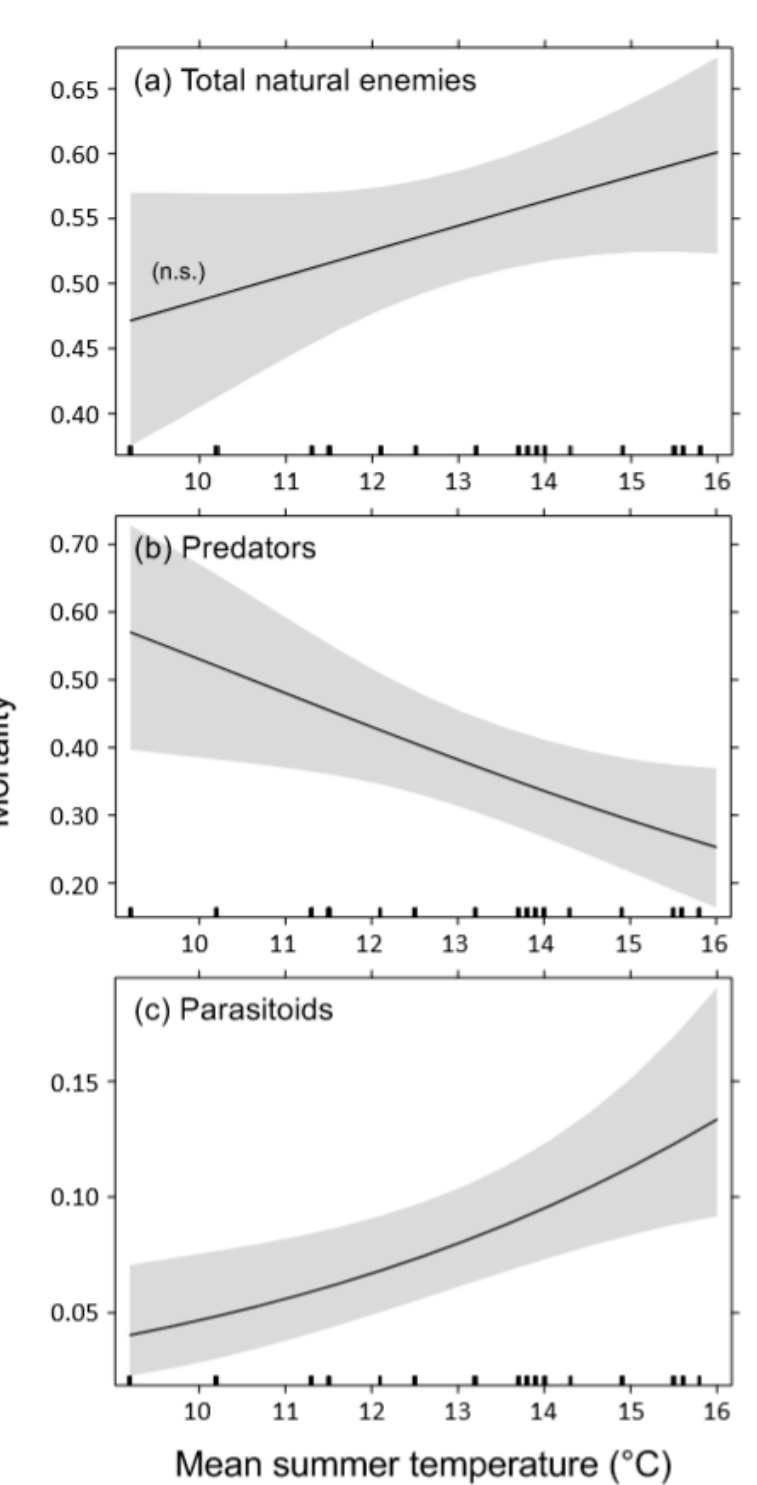
Figure 2. Relationships between mean summer temperatures and bark beetle mortality inflicted by ( a ) total natural enemies, ( b ) predators, and ( c ) parasitoids. The shaded areas indicate the 95% confidence bands. The rug plots at the bottom of the graphs show the values measured in this study. Statistical details are given in Table S1.